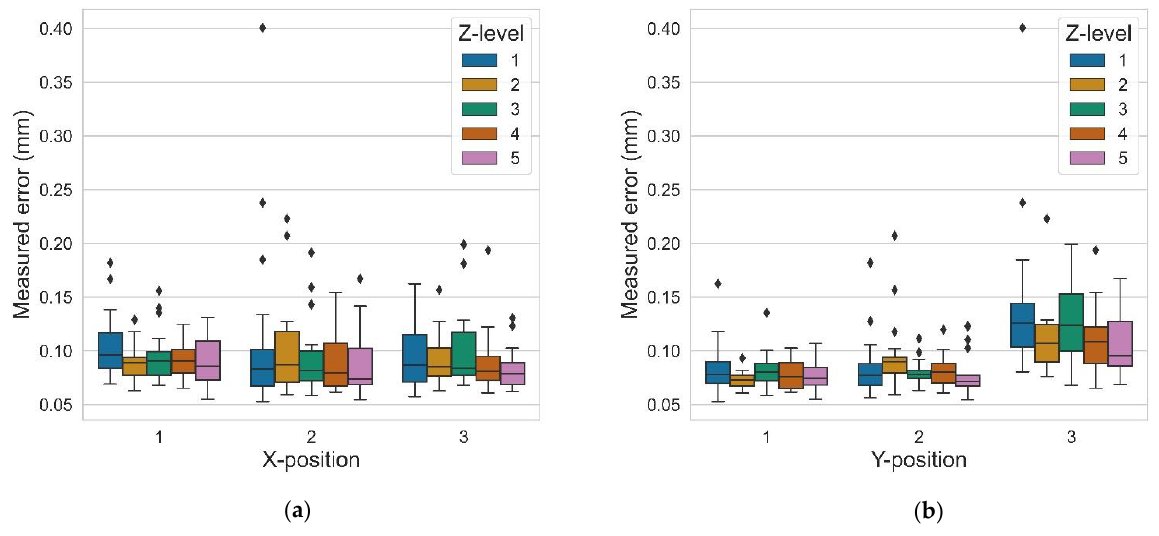
Figure 24. Boxplot for measured flatness error of vertical planes at different positions. ( a ) The rows along the x-axis at different z-levels; ( b ) the rows along the y-axis at different z-levels.